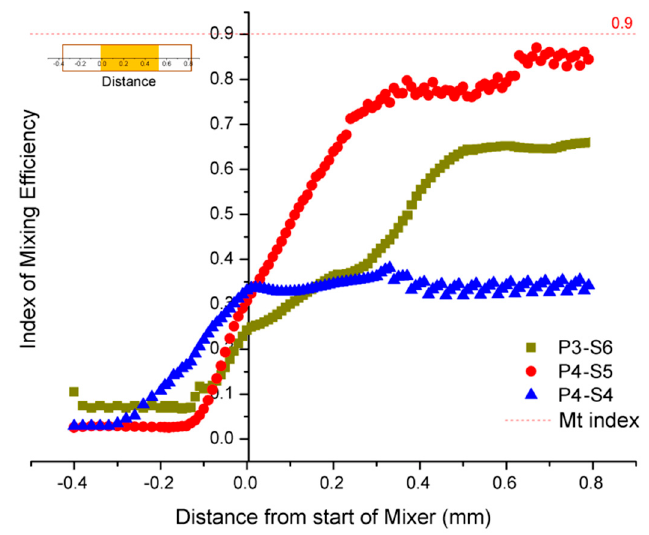
Figure 5. Computational fluid dynamics (CFD) simulations showing the distribution of velocity magnitude along the x-axis, which is generated by staggered microspheres in three different mix- ing channels.